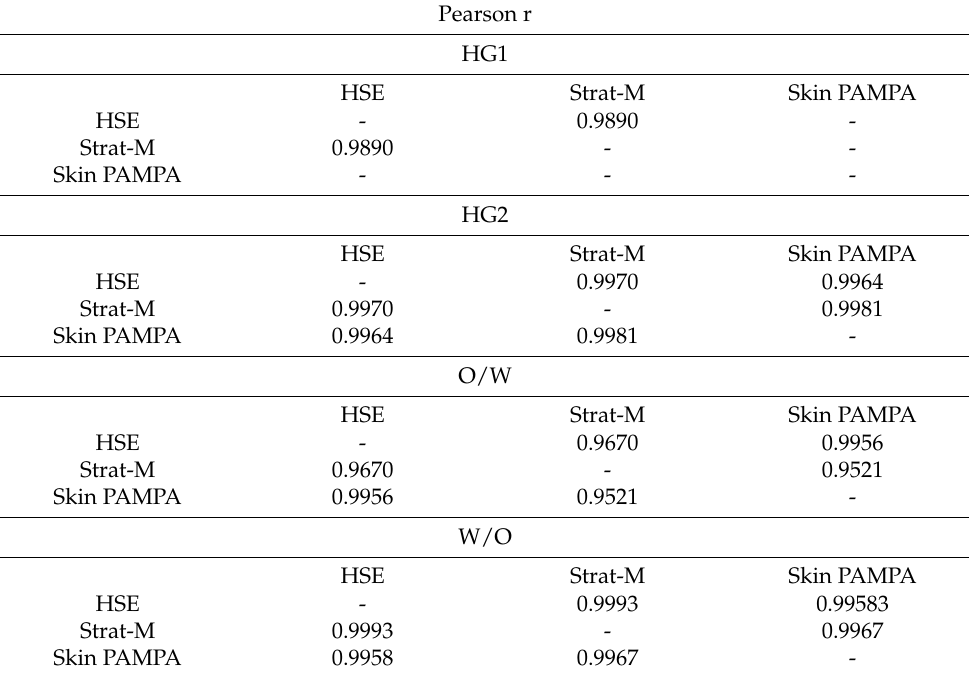
Table 2. Correlation matrix of the permeation curves of the different formulations applying different